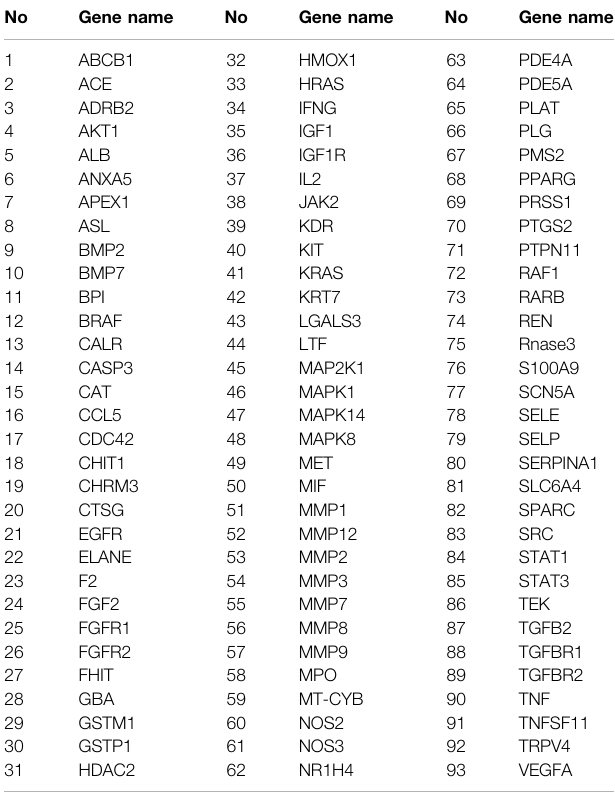
TABLE 3 | The 93 hub targets between 36 active components of WBT formula and pulmonary fi